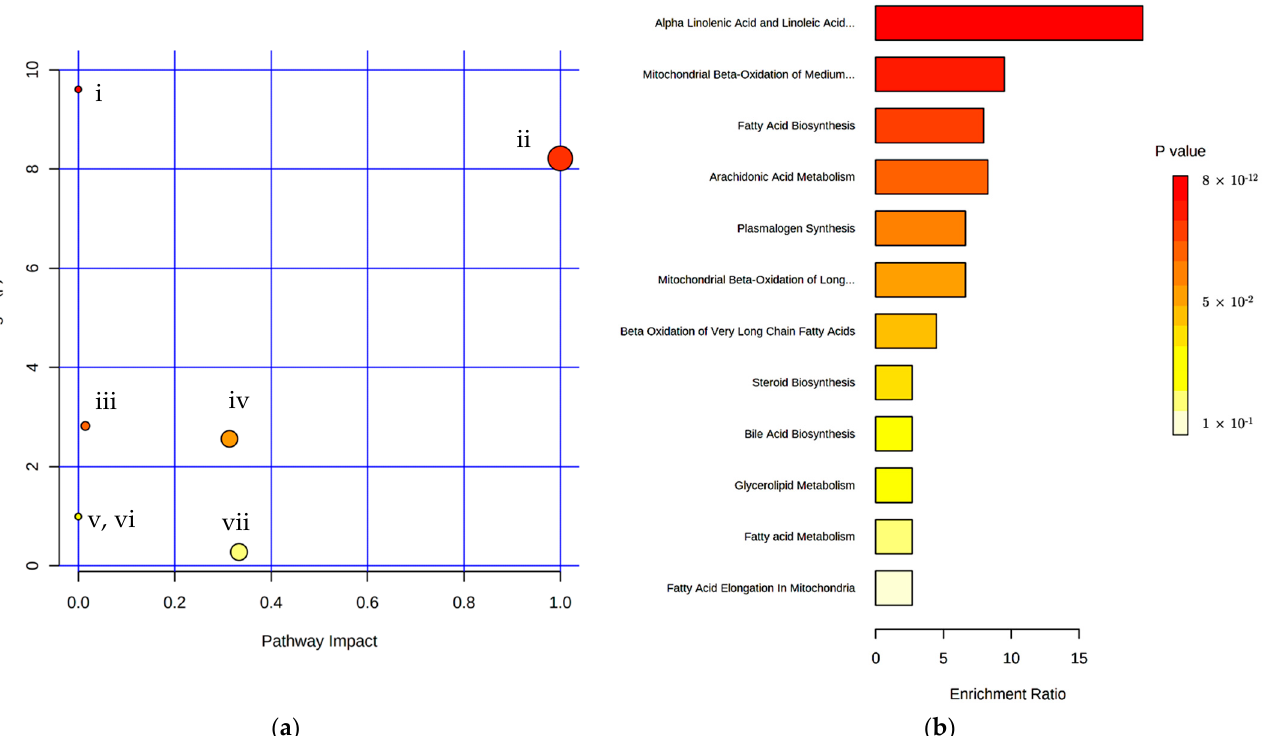
Figure 8. ( a ) Summary of pathway analysis: (i) Biosynthesis of unsaturated fatty acids; (ii) Linoleic acid metabolism; (iii) Fatty acid biosynthesis; (iv) Arachidonic acid metabolism; (v) Fatty acid elongation; (vi) Fatty acid degradation; (vii) alpha-Linolenic acid metabolism. ( b ) Quantitative enrichment analysis (QEA): Metabolite set enrichment overview. * Features 16, 38, and 39 (13-Octadecenoic acid, methyl ester; Cholesta-3,5-diene; Cholesta-2,4-diene) were excluded due to lack of metabolite ID (HMDB ID) conversion match.